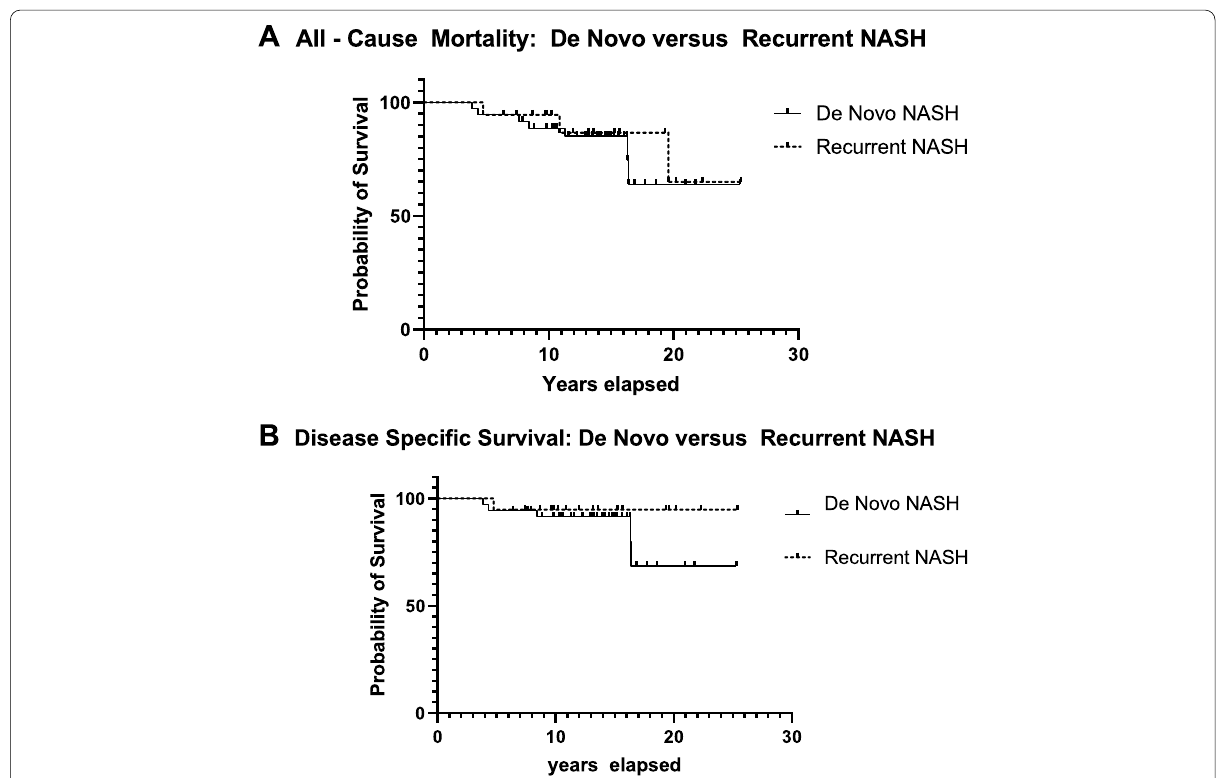
Fig. 1 A Survival curves with all cause mortality in patients with de novo versus recurrent non‑alcoholic steatohepatitis (NASH). There is no difference in all cause mortality by Log‑rank (Mantel‑Cox) test ( p 0.6479). B Survival curves with disease specific mortality in patients with de novo = versus recurrent non‑alcoholic steatohepatitis (NASH). There is no difference in disease specific mortality by Log‑rank (Mantel‑Cox) test ( p =